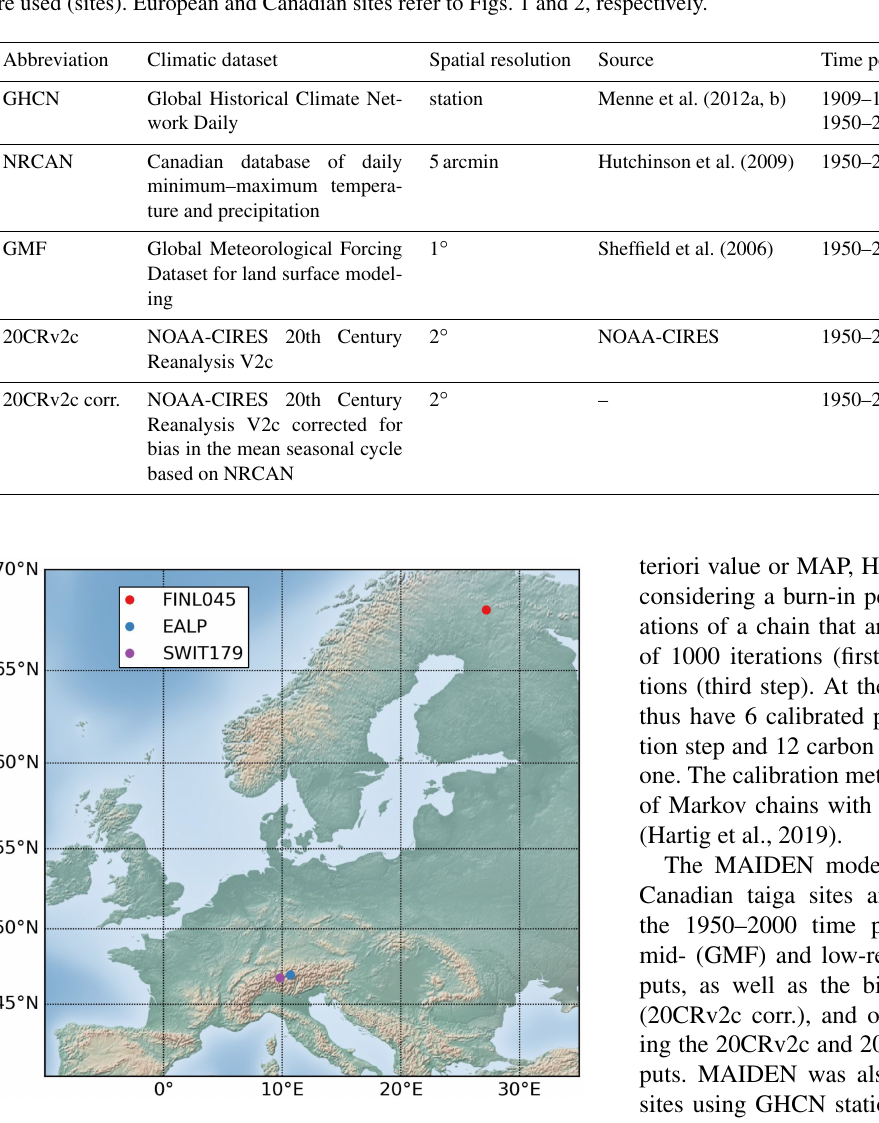
Table 2. Description of all daily climatic datasets used in this study (abbreviation, climatic dataset, spatial resolution and source), time periods on which MAIDEN and VS-Lite simulations are performed with each specific climatic dataset (Time period), and sites where climate data are used (sites). European and Canadian sites refer to Figs. 1 and 2, respectively.